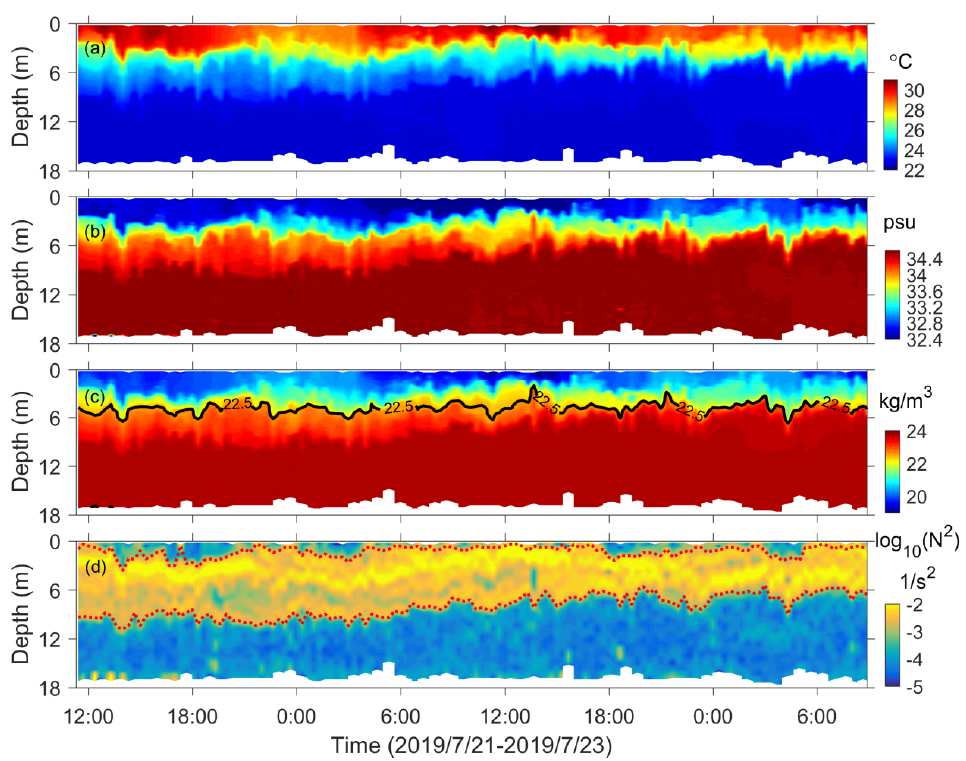
Figure 13. Time courses of ( a ) temperature, ( b ) salinity, ( c ) density, and ( d ) buoyancy frequency as measured by YODA in July 2019. The black line in ( c ) indicates a density of 1022.5 kg/m 3 . Red dotted lines in ( d ) indicate the surface and bottom mixed layers.